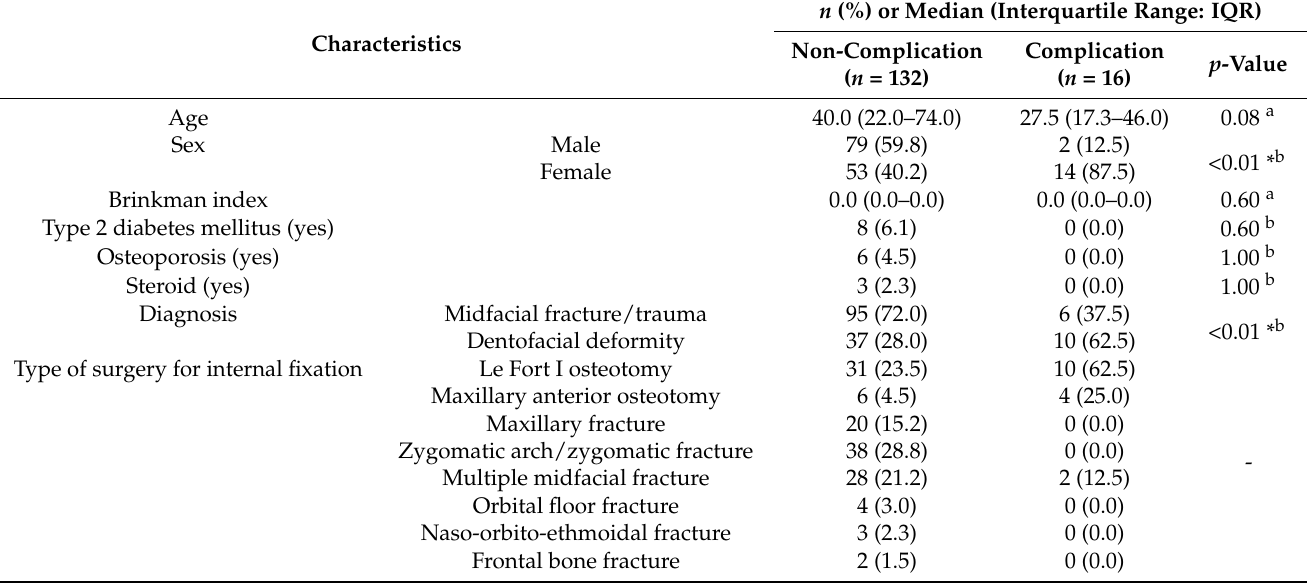
Table 2. Comparison of background factors between non-complication and complication groups ( n = 148).